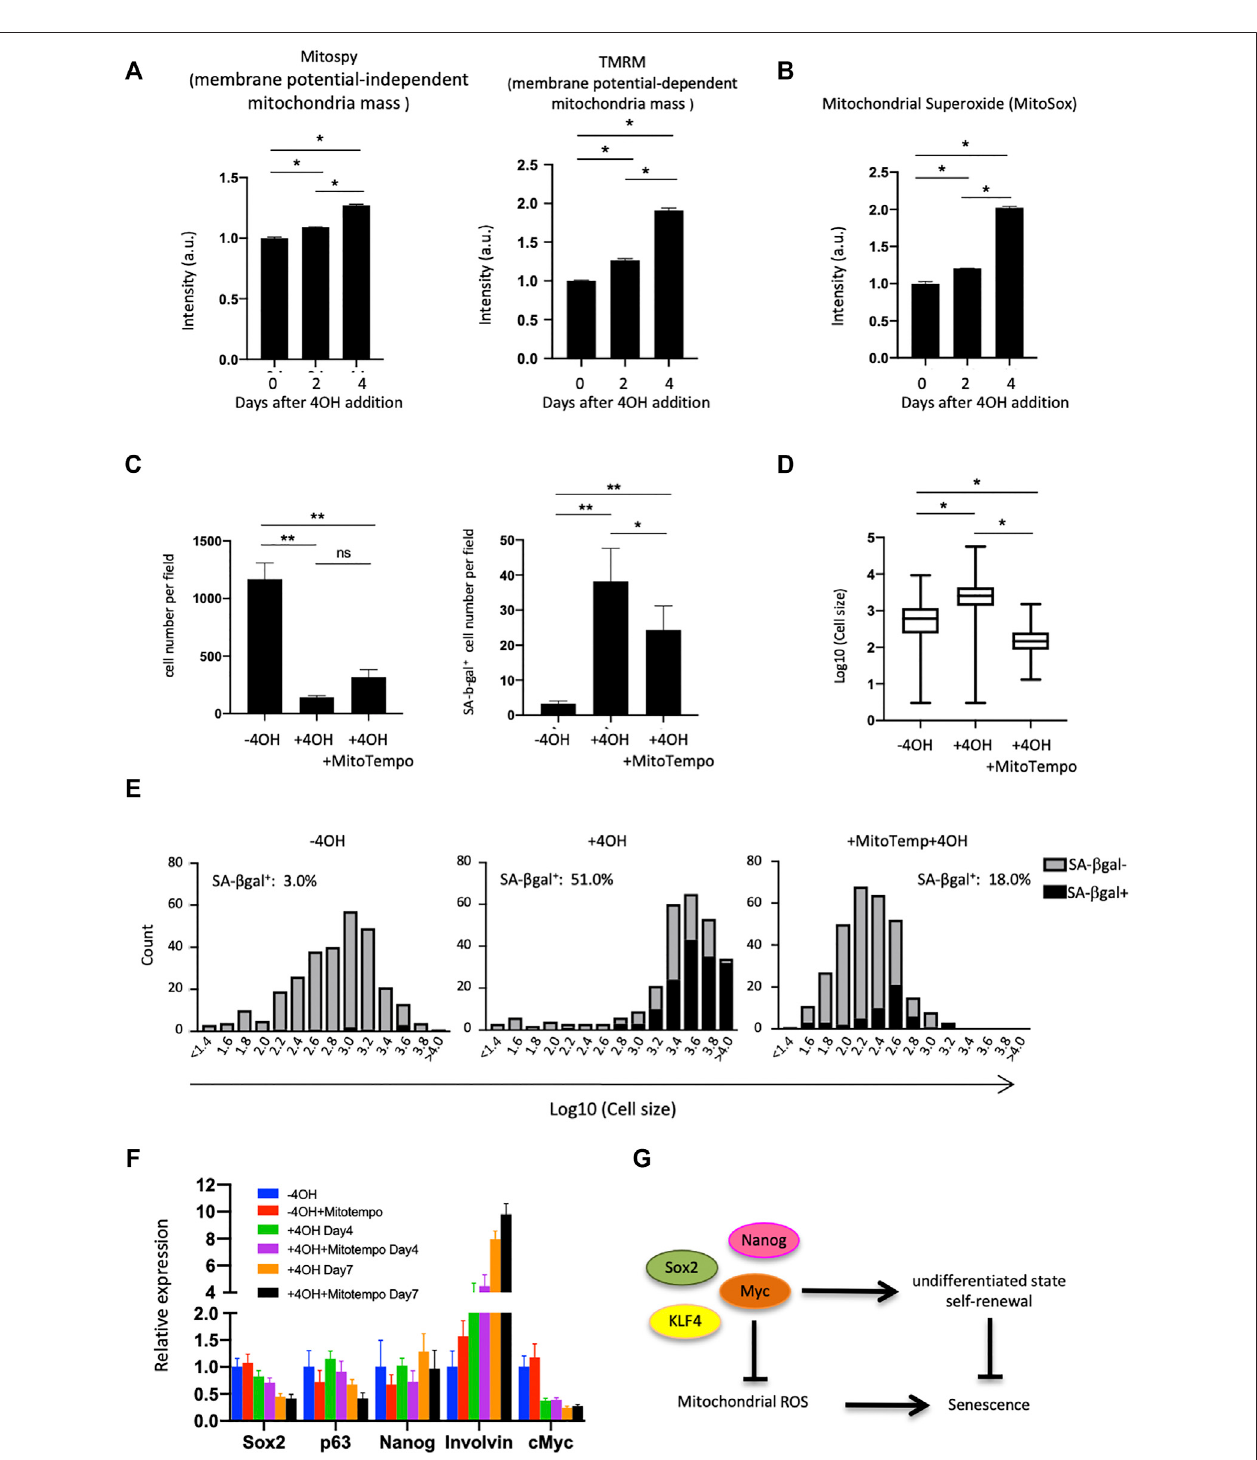
FIGURE 4 | Mitochondrial analysis in Myc cdKO mEPCs. (A) Mitochondrial quantity and activity in Myc cdKO mEPCs treated for 2 days. Data represent the mean with SD ( n = 3). * p < 0.0001. (B) Mitochondrial superoxide levels in 4OH-treaed cells. Data represent the mean with SD ( n = 3). * p < 0.0001. (C) Rescue effect of Mitotempo.Left,representativeimageofeachcondition.Right,quanti fi cationoftotalcellnumber.DatarepresentthemeanwithSE. ns =non-signi fi cant,* p < 0.05,** p < 0.0001. (D) Rescue effect of Mitotempo on cell size. * p < 0.0001. (E) Histogram of the cell size distribution. (F) qPCR analysis for Mitotempo-rescued cells. Data represent the mean with SD ( n = 3). (G) Proposed model of Myc function supporting self-renewal of the esophageal basal cells.